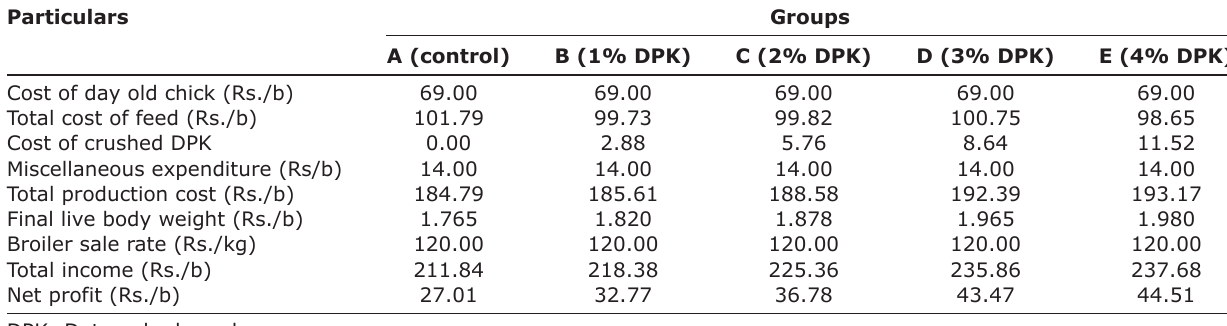
Table-4: Economic aspects of broiler rations as affected by feeding various levels of DPK.